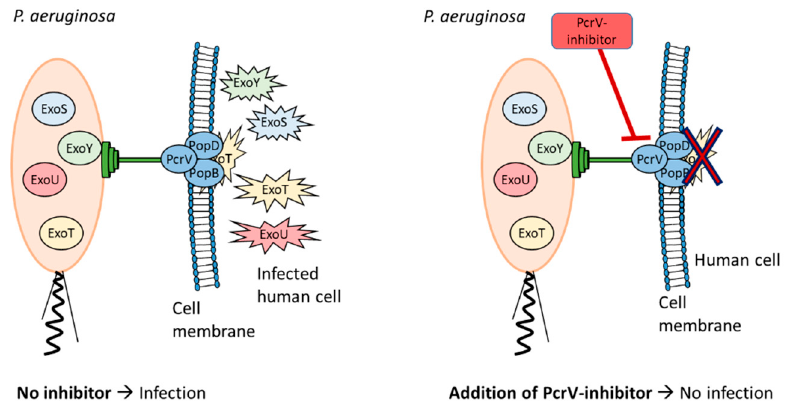
Figure 1. Schematic representation of the type III secretion system (T3SS): the T3SS has a syringe- like structure with two rings spanning the bacterial membranes and a needle protruding from the surface with the PcrV protein at its tip. Upon contact with the eukaryotic cell, the exoenzymes are translocated into the eukaryotic cell via the translocation-pore (PopB and PopD), which is dependent on the PcrV protein for its function. A PcrV inhibitor will block translocation, and no toxins will be transported into the eukaryotic cell.